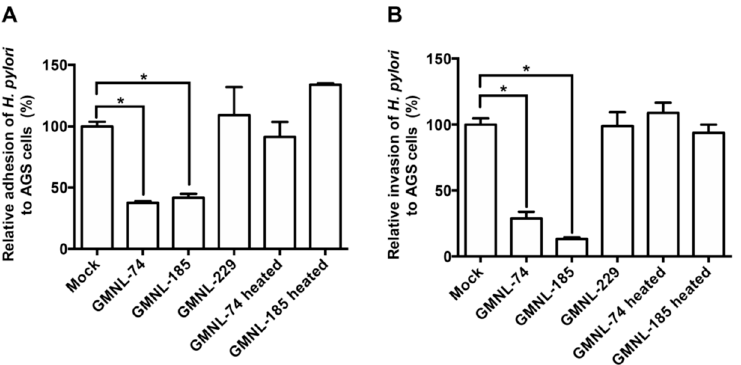
Figure 1. Effects of Lactobacillus spp. on H. pylori ( A ) adhesion and ( B ) invasion into gastric epithelial cells. AGS cells were treated with live Lactobacillus spp. (GMNL-74, 185, and 229) or heat-inactivated Lactobacillus spp. (GMNL-74 and 185), followed by infection with H. pylori 26695 at multiplicity of infection (MOI) 100 for 6 h. Each experiment result shows the mean ± standard deviation of three independent experiments. *, p < 0.01.